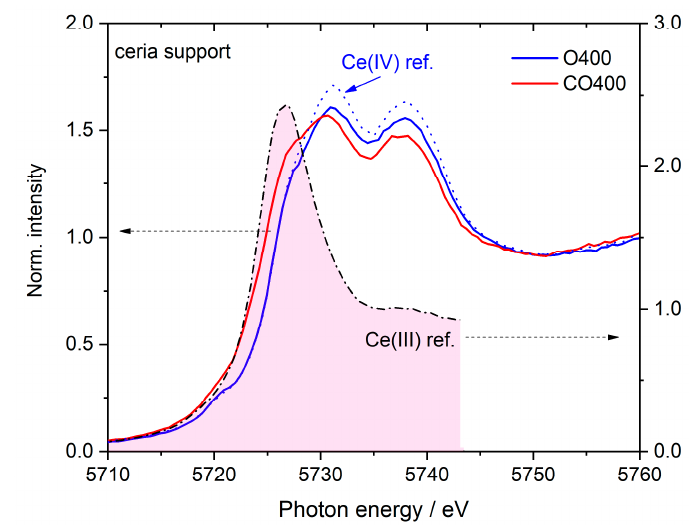
Figure 2. Spectra of the high-surface-area CeO 2 support recorded after an O400 (blue solid line) and a CO400 (red solid line) pretreatment. Dashed lines denote the respective data from the Ce references; black: Ce(III), blue: Ce(IV). Note that the Ce(III) reference (black dashed line) has been re-scaled in intensity for similar height as in the other spectra (scale on the right side).